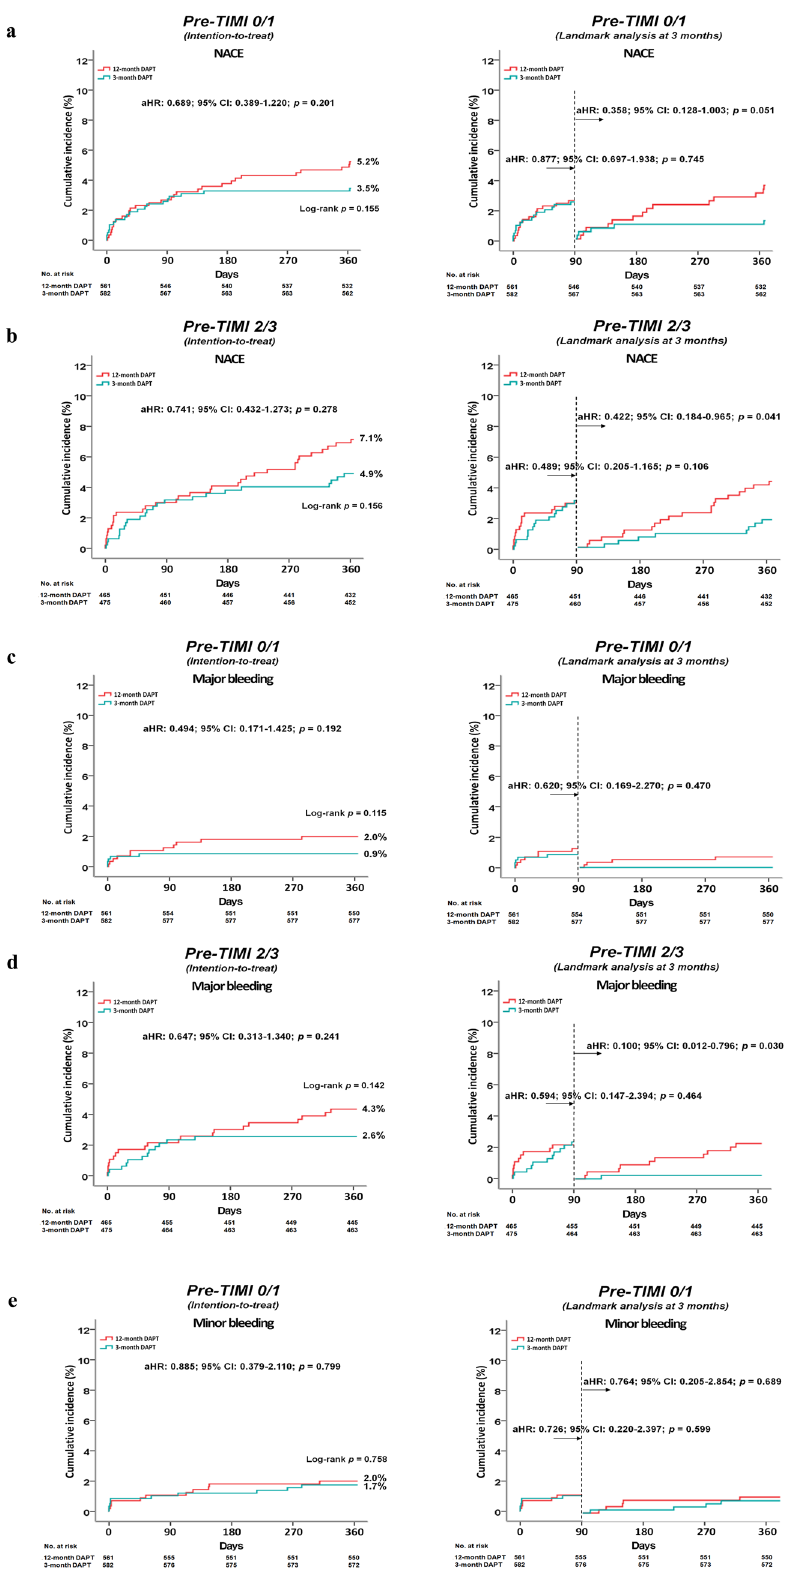
Figure 1. Time-to-event curves for NACE ( a and b ), TIMI major bleeding ( c and d ), TIMI minor bleeding ( e and f ), TIMI major or minor bleeding ( g and h ), and MACCE ( i and j ) in pre-PCI TIMI flow grade 0/1 ( a , c , e , g , and i ) and 2/3 groups ( b , d , f , h , and j